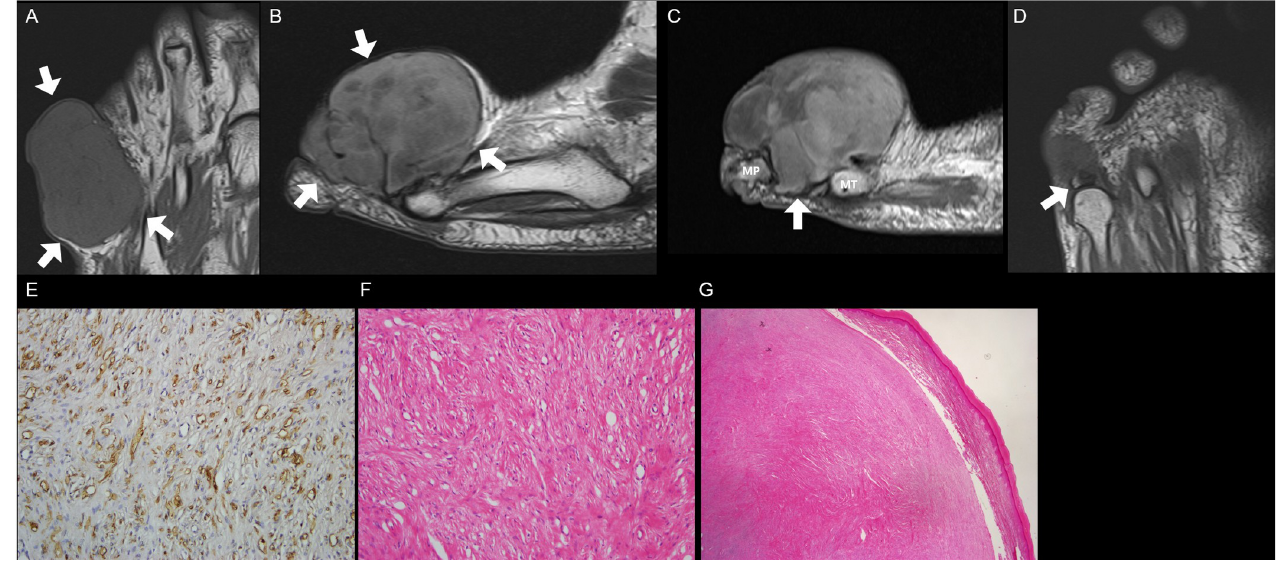
Fig 3. A 59-year old woman with digital ancient schwannoma on the dorsal side of the 5 th proximal phalanx of the foot. (A) On coronal T1-weighted image, the mass shows isointense SI compared to the skeletal muscle (arrows). ( B) On sagittal T2-weighted image, the mass reveals lobulation in shape and heterogeneously hyperintense SI compared to skeletal muscle (arrows). ( C) On sagittal contrast-enhanced T1-weighted image, the mass demonstrates heterogeneous enhancement with bone destruction of proximal phalanx (arrow). ( D) On coronal T1-weighted image, the proximal phalanx focally remains with preserved normal fatty marrow (arrow). ( E) Immunohistochemically (S100X200), tumor cells are equivocally positive for S-100 protein. ( F) Benign neurogenic tumor with hyalinization, suggestive of schwannoma with ancient change (H&E, X200). ( G) The expanding mass with well encapsulated fibrous capsule is in close proximity to the adjacent epidermis but not invades (H&E, X40). SI , signal